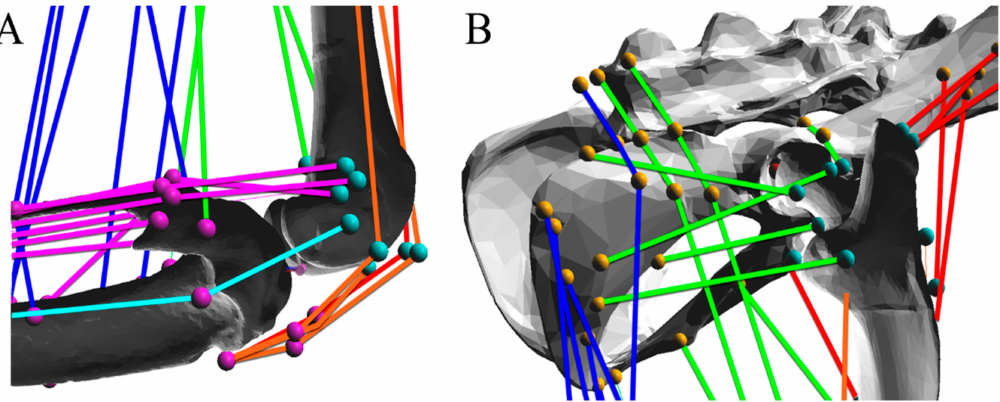
Figure 2. Muscle paths were determined based on anatomical descriptions and diagrams from Greene [21]. Enlargements of ( A ) the knee and ( B ) hip detail the complex interconnection of muscle attachment points. Attachment points are stationary within local bone coordinate systems. Attachment points are carefully placed such that there is no bone pass-through during the physiological representative walking cycle.